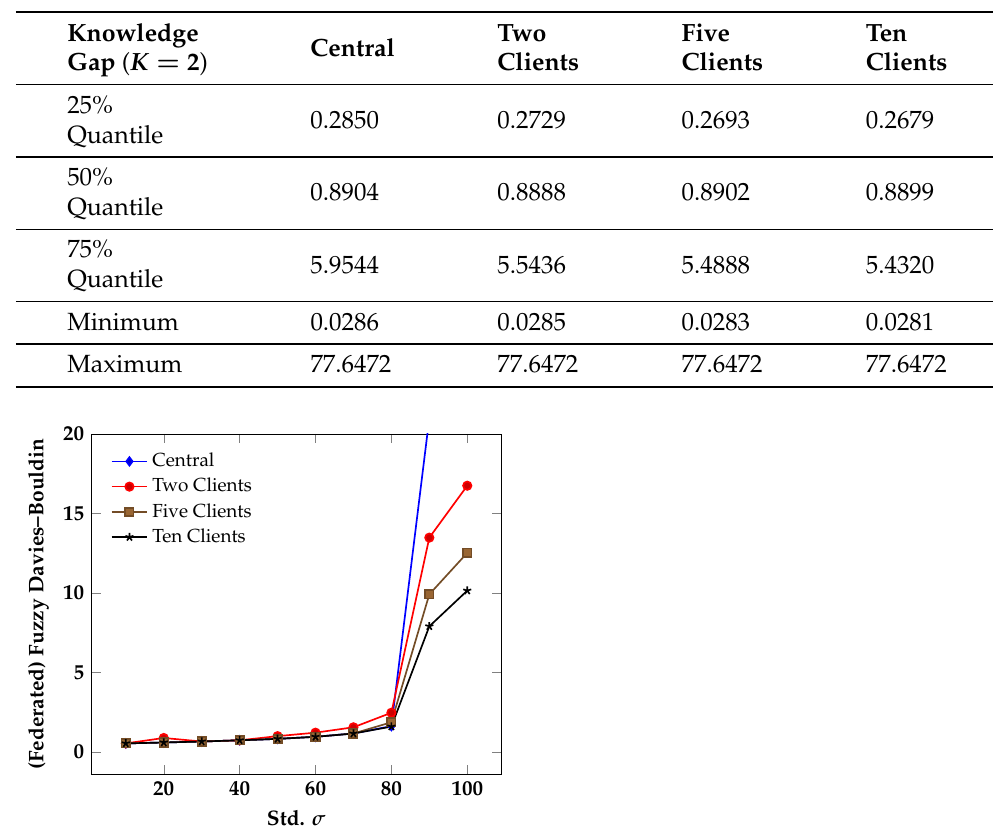
Table 7. Statistics of the knowledge gap on the 100 G2 test sets with federated averaging.